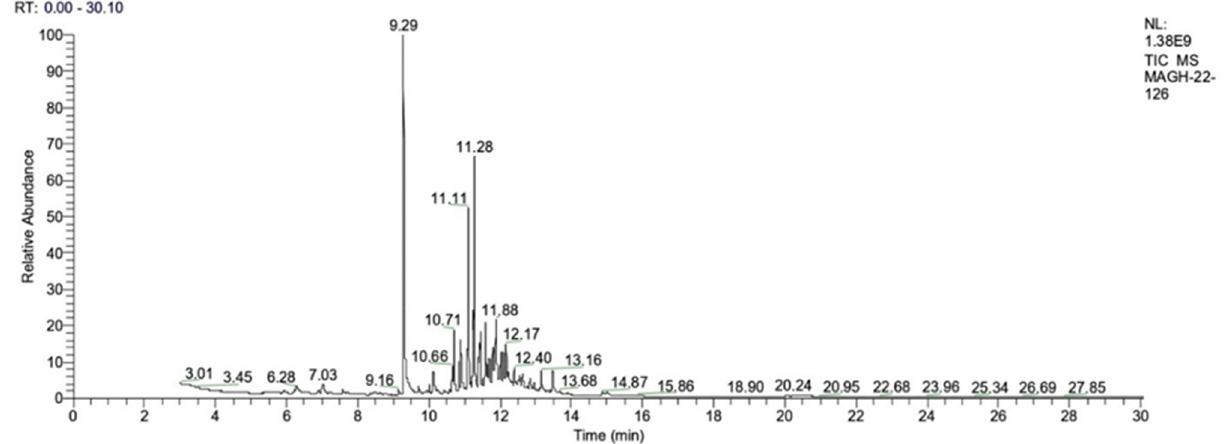
Figure 4. Chromatogram of Piper cordoncillo essential oil obtained by GC-MS.